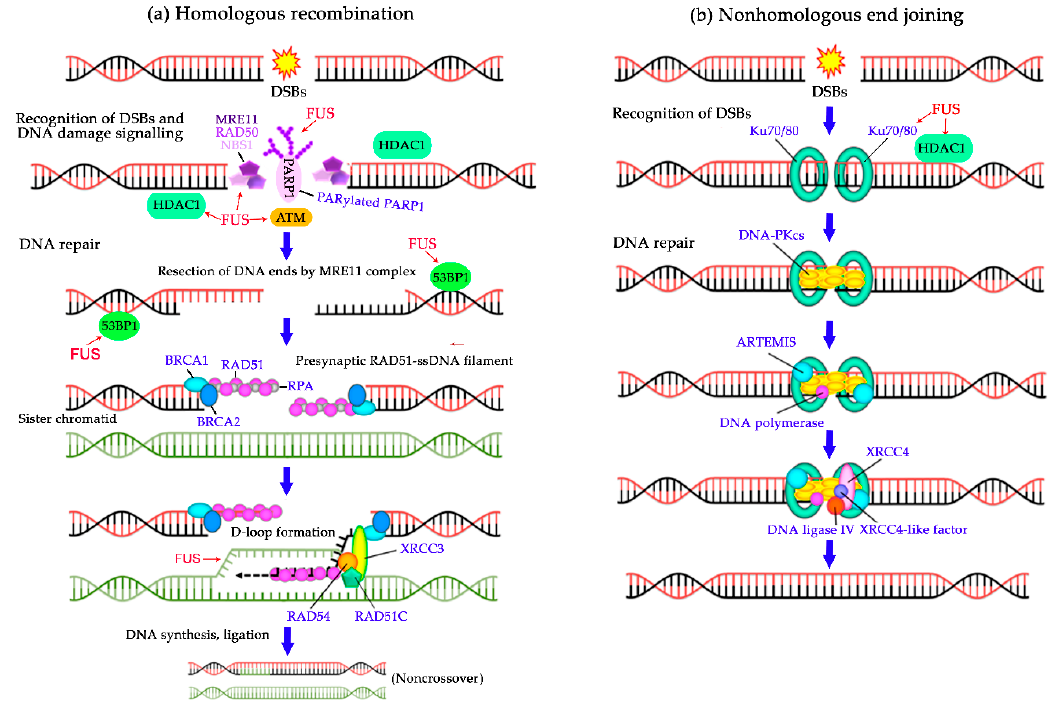
Figure 3. The involvement of FUS in double-strand DNA break (DSB) repair pathways. Schematic overview of HR, NHEJ illustrating basic steps of these pathways along with the proteins implicated in each step [86]. ( a ) The influence of FUS on HR. Simplified scheme for HR. The Mre11/Rad50/NBS1 complex starts resection on the DSBs to generate single stranded DNA. The ssDNA is first coated by Replication protein A (RPA), which is subsequently replaced by Rad51 with the help of BRCA1 and BRCA2. These Rad51 nucleoprotein filaments mediate strand invasion on the homologous template. The invading 3 ′ -end of ssDNA serves as a primer for DNA synthesis. D-loop strands extended by DNA repair synthesis dissociate from their sister chromatid complements and reanneal with their original complementary strands. Additional DNA synthesis in the reannealed DNA duplex and ligation of the remaining single strand nicks complete the repair in the case of synthesis-dependent strand-annealing model of D-loop resolution, forming non-crossover products. FUS interacts with histone deacetylase 1 (HDAC1) and PARylated PARP1, binds to a D-loop intermediate and affects DSB-dependent accumulation of ATM (Ataxia-telangiectasia mutated serine-proteins kinase), NBS1 (Nijmegen breakage syndrome 1) and 53BP1 (p53-binding protein 1) [37,49]. ( b ) The effect of FUS on NHEJ. Simplified scheme for NHEJ. The two broken DNA ends are processed by the action of the end-binding Ku70/80 heterodimer complex, DNA-dependent protein kinase, catalytic subunits, (DNA-PKcs), artemis, DNA polymerase and ligated by DNA Ligase IV-XRCC4 complex. FUS interacts with HDAC1 and affects accumulation of Ku70/80 at DSBs [37].